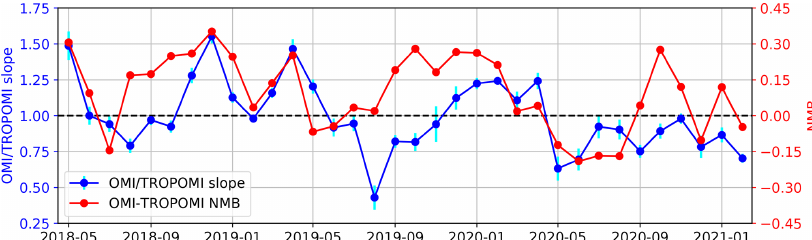
Figure A2. OMI / TROPOMI OLS slope (blue) and OMI–TROPOMI NMB (red) for each month when TROPOMI NO 2 TVCD data are available for